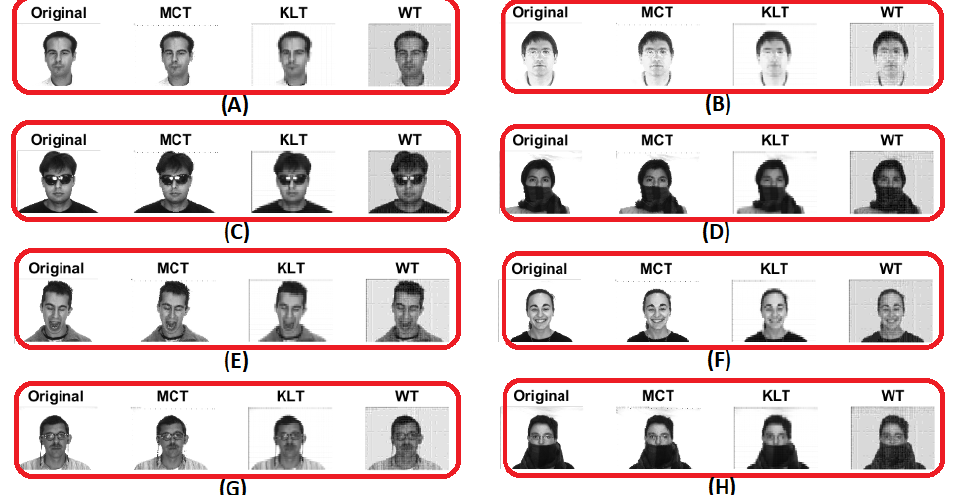
Figure 11. A visual comparative evaluation applied on full image of AR database: ( A ) Neutral expression face during first session, ( B ) wearing prescription eyeglass with both side light on during first session, ( C ) wearing sunglasses during second session, ( D ) wearing scarf and right light on during second session, ( E ) Scream during first session, ( F ) Smile face wearing prescription eyeglassduring first session, ( G ) Anger face during first session, ( H ) Anger face wearing scarf and prescription eyeglasses during first